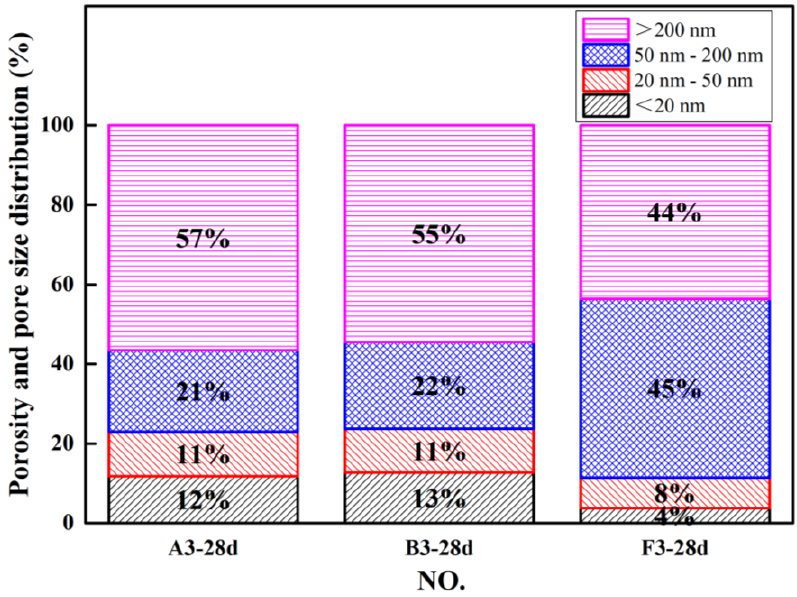
Figure 9. Pore structure of some samples with different cement agents.